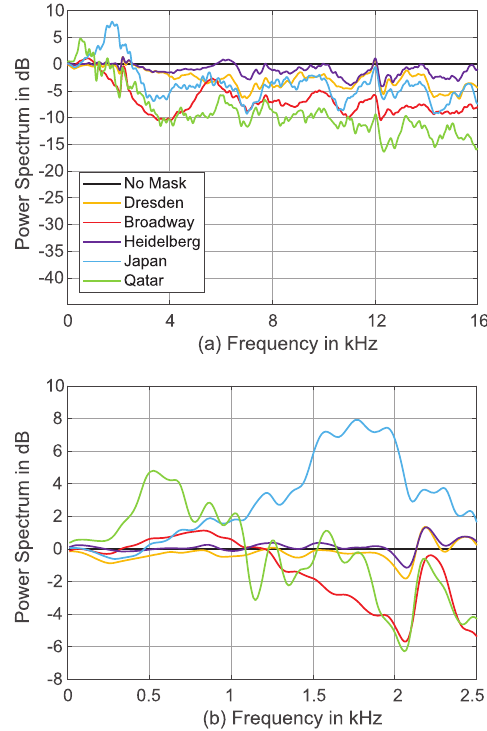
Figure 3. (a) Power spectrum of the singing masks averaged over azimuth angle u in dB as function of the frequency from 50 Hz to 16 kHz in reference to task without a mask using white Gaussian noise as sound signal. (b) Enlarged representation in the range between 500 Hz and 2.5